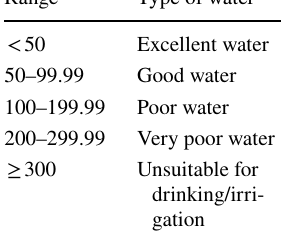
Table 3 Quality of water classification range and water type based on WQI